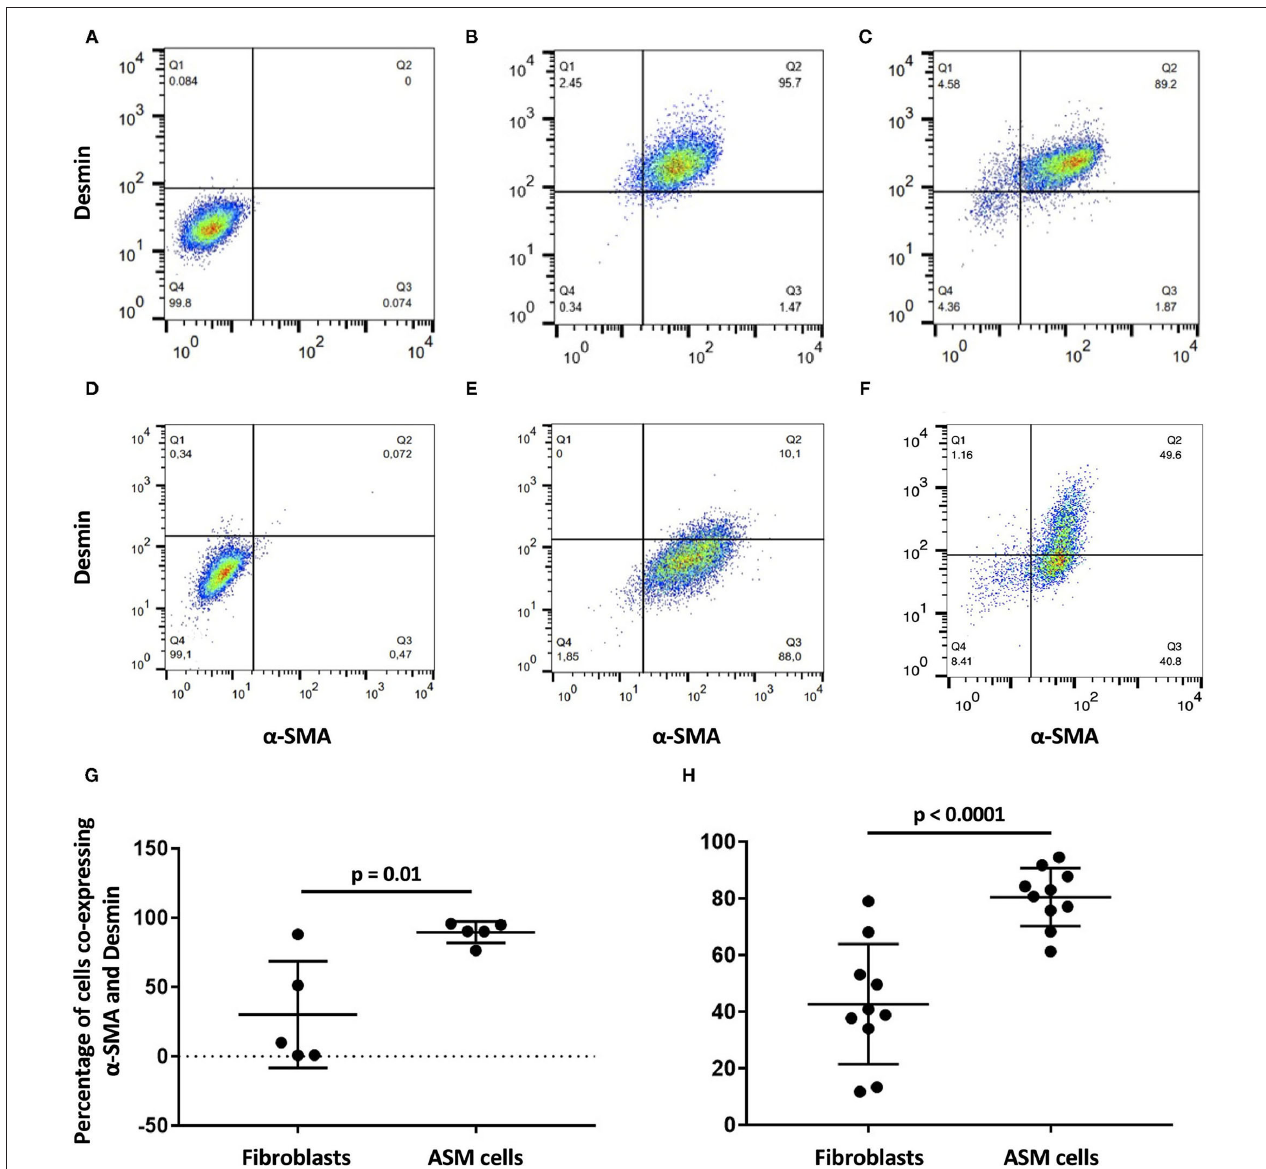
FIGURE 1 | α -SMA and desmin co-expression in airway smooth muscle (ASM) cells and fibroblasts by flow cytometry. Isotype control quadrant for α -SMA and desmin co-expression, respectively, for (A) ASM cells and (D) fibroblasts (D) . (G) Percentage of α -SMA and desmin co-expression is significantly higher in (B) ASM cells than (E) fibroblasts before recellularization. (H) Significance is maintained after recellularization [ (C) ASM cells and (F)